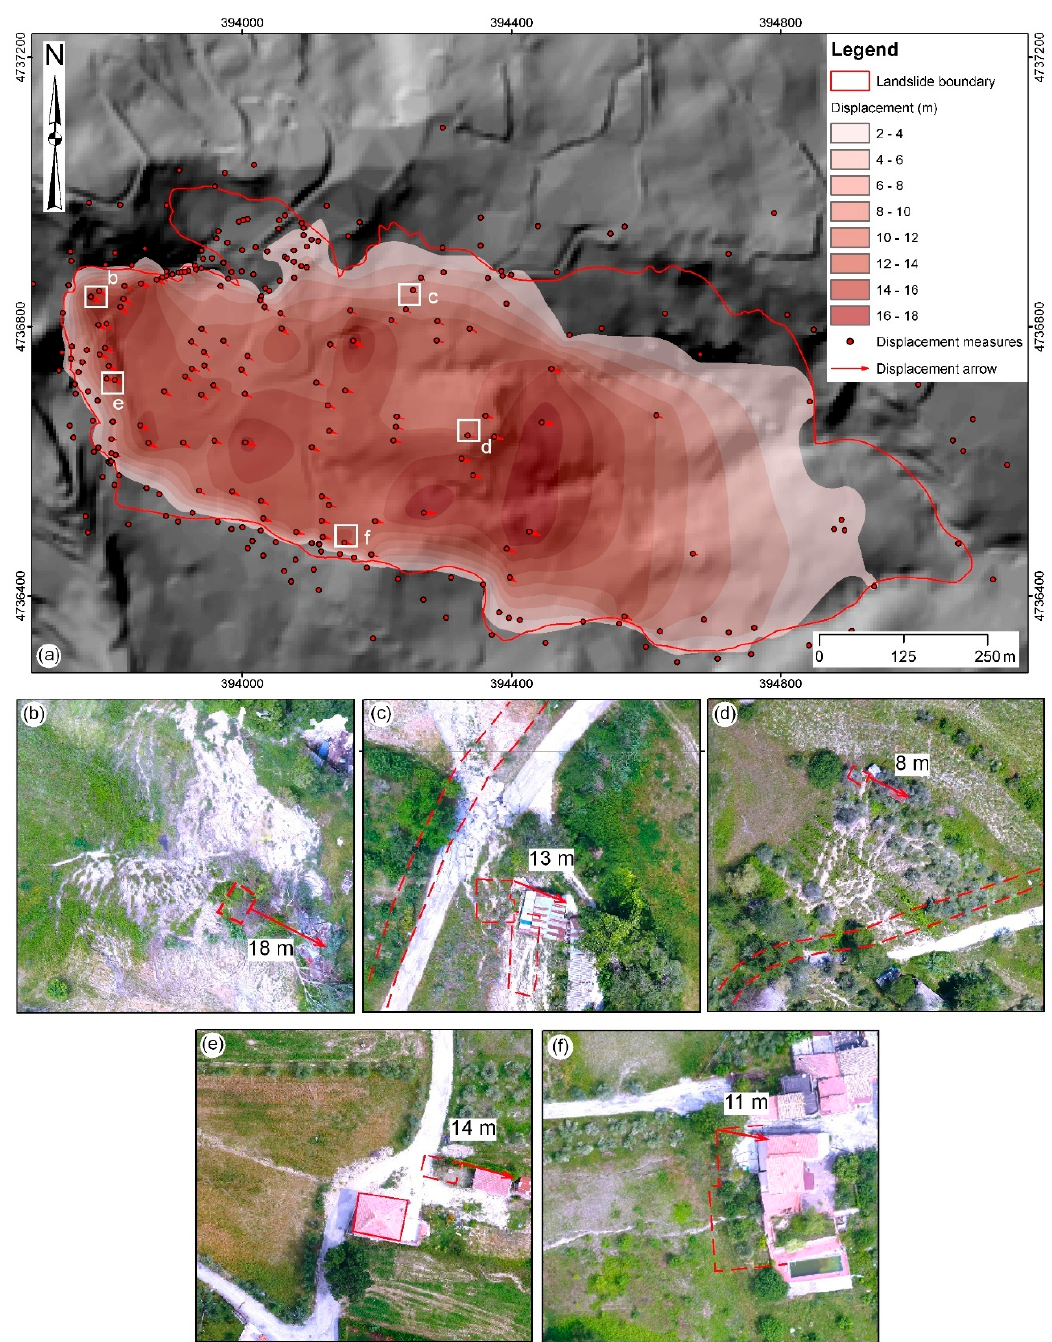
Figure 11. ( a ) Displacement distribution in the Ponzano landslide. ( b – f ) Significant measurement points observed in the landslide area; the image is derived from UAV post-landslide orthophoto and the red dashed lines mark the pre-landslide locations (derived from 2010 orthophotos); the measurement location is in (a).